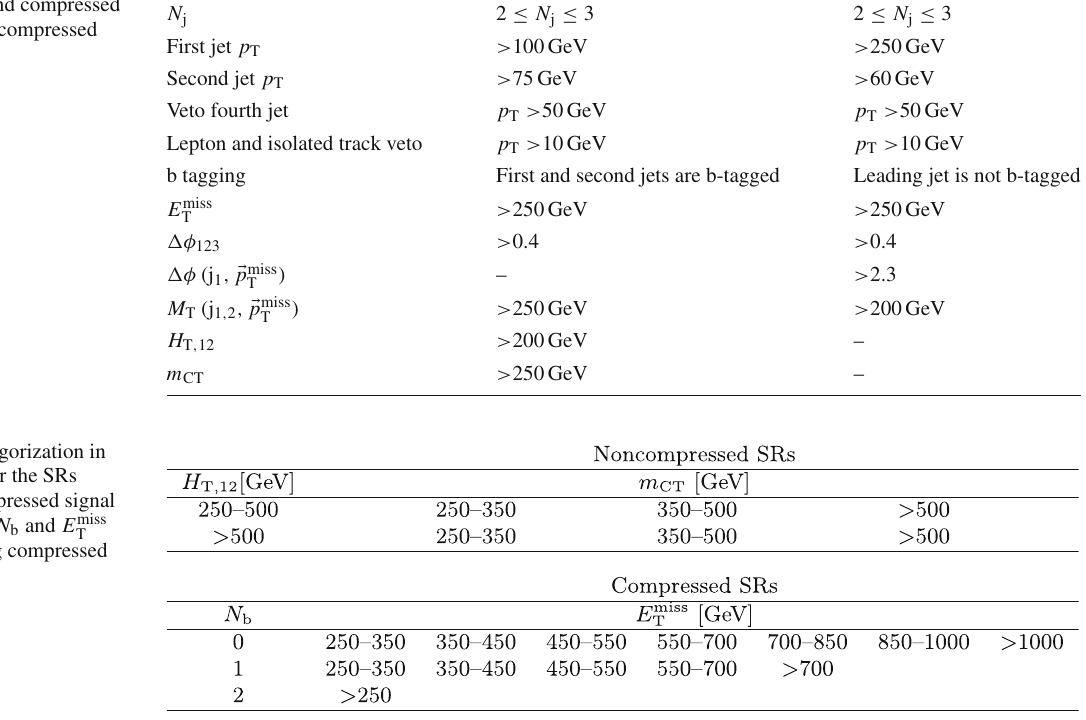
Table 5 A summary of the baseline selections used for the noncompressed and compressed (cid:2) b (cid:2) t → c (cid:2) χ 0 compressed 1 and 1 1